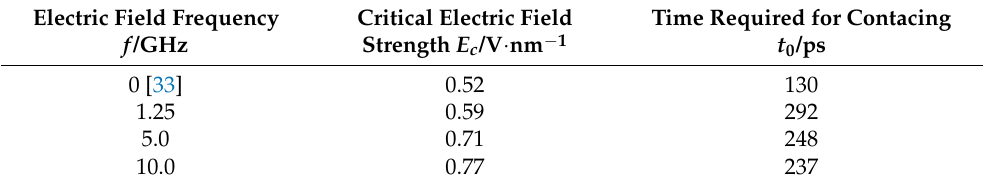
Figure 3. Dynamic coalescence and separation process of the two droplets under electric fields E = E c (shown by subscript 1) and E = E c + 0.01 V/nm (shown by subscript 2) when the electric field frequencies are ( a ) f = 1.25 GHz, ( b ) f = 5.0 GHz and ( c ) f = 10.0 GHz. L and H represents the length and the height of the droplet. Table 2. Electric field frequency f dependents of critical electric field strength ( E c ) and time required for contacting ( t 0